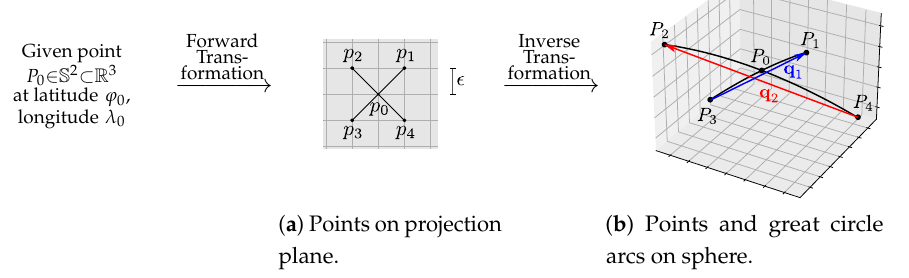
Figure 1. Schematic diagram of sample points and spherical arcs for GCA-based metrics. ( a ) Points on projection plane; ( b ) Points and great circle arcs on